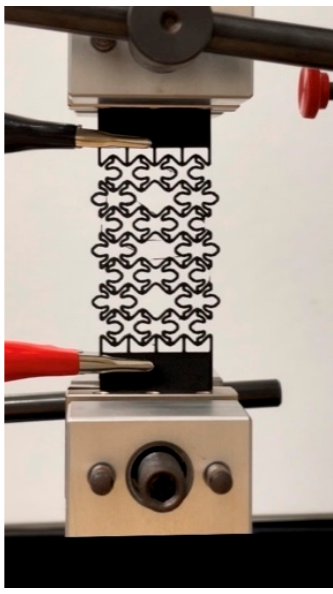
Figure 4. Image of structure for tensile test.